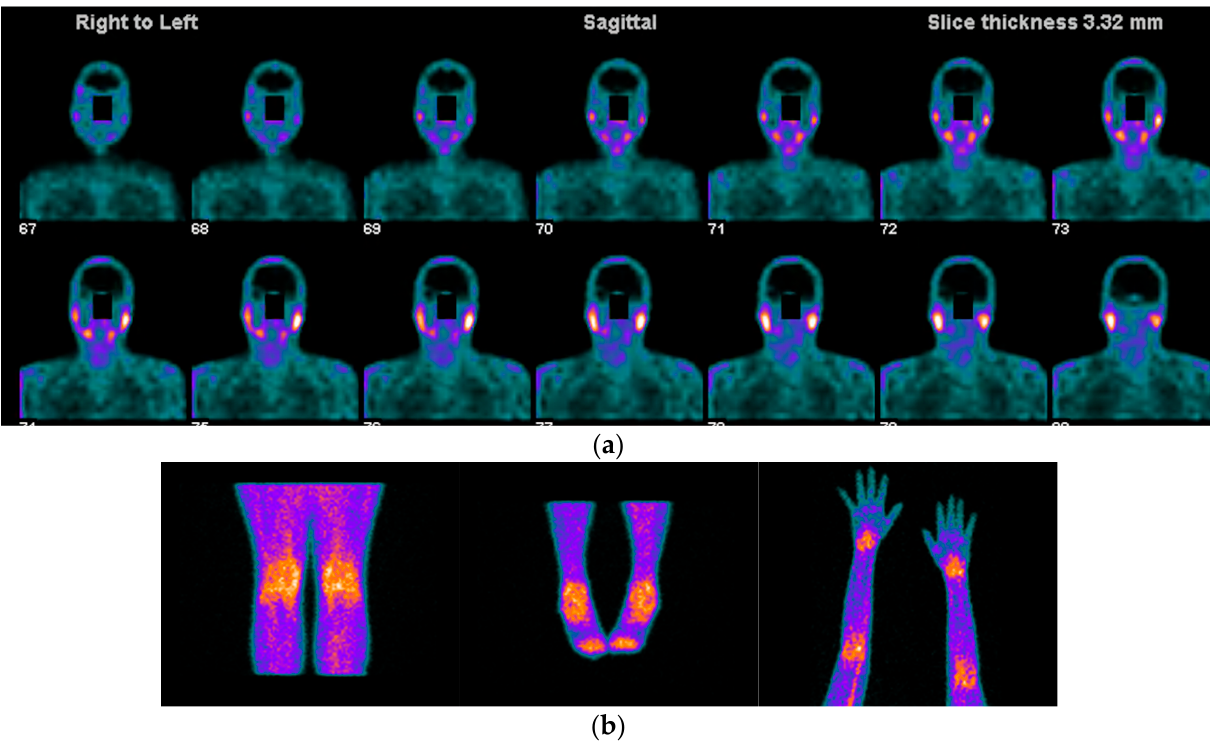
Figure 3. Images acquired after 99m Tc-HYNIC-TOC administration i.v in a patient with SS, sicca symptoms, and painful joints. In ( a ) high abnormal uptake in parotids and submandibular salivary glands. In ( b ) shows high abnormal uptake in knees, ankles, elbows, and carpal joints.